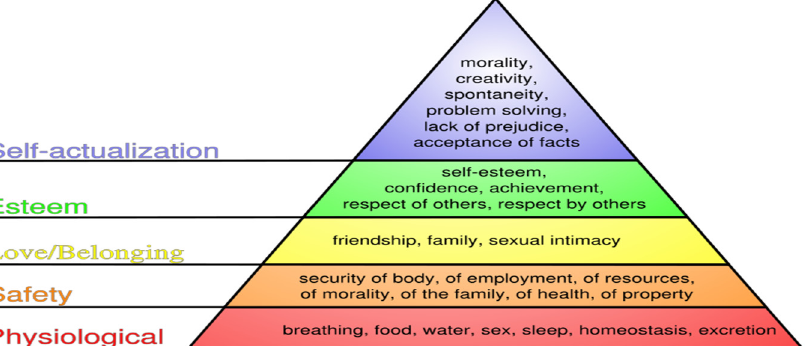
Figure 1. Maslow’s Hierarchy of Human Needs [5].